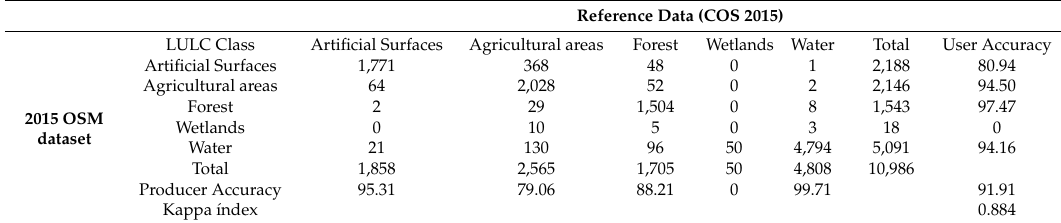
Table 8. Thematic accuracy for 2015 (in